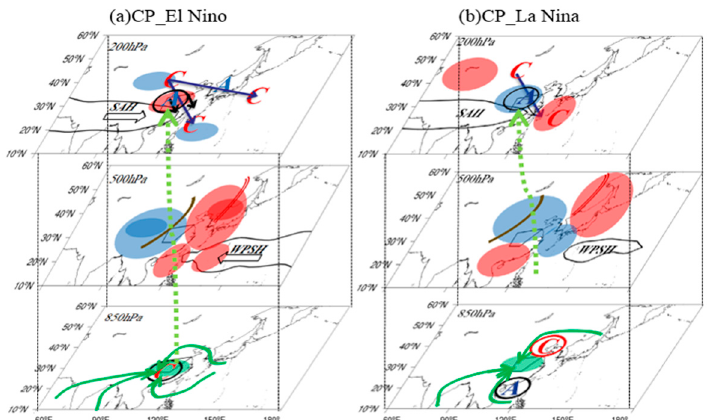
Figure 11. Schematic diagrams for circulation anomalies of CP El Nino ( a ) and CP La Nina ( b ) responsible for low-frequency precipitation in eastern China. The letters ‘C’ and ‘A’ represent the low-frequency cyclone and anticyclone, respectively. The black arrow denotes WAF transport, and the blue arrow represent the low-frequency wave train. The black solid lines at 200 hPa and 500 hPa denote the boundary of the SAH and Western Pacific Subtropical High (WPSH). Mid-latitude trough and ridge at 500 hPa is indicated by brown and red lines respectively. The red (blue) shading at 200 hPa and 500 hPa represent low-frequency height positive (negative) anomaly. The low-frequency water vapor convergence and water vapor channels at 850 hPa are presented as green shading and green lines respectively. Green dashed arrow represents low-frequency ascending motion.